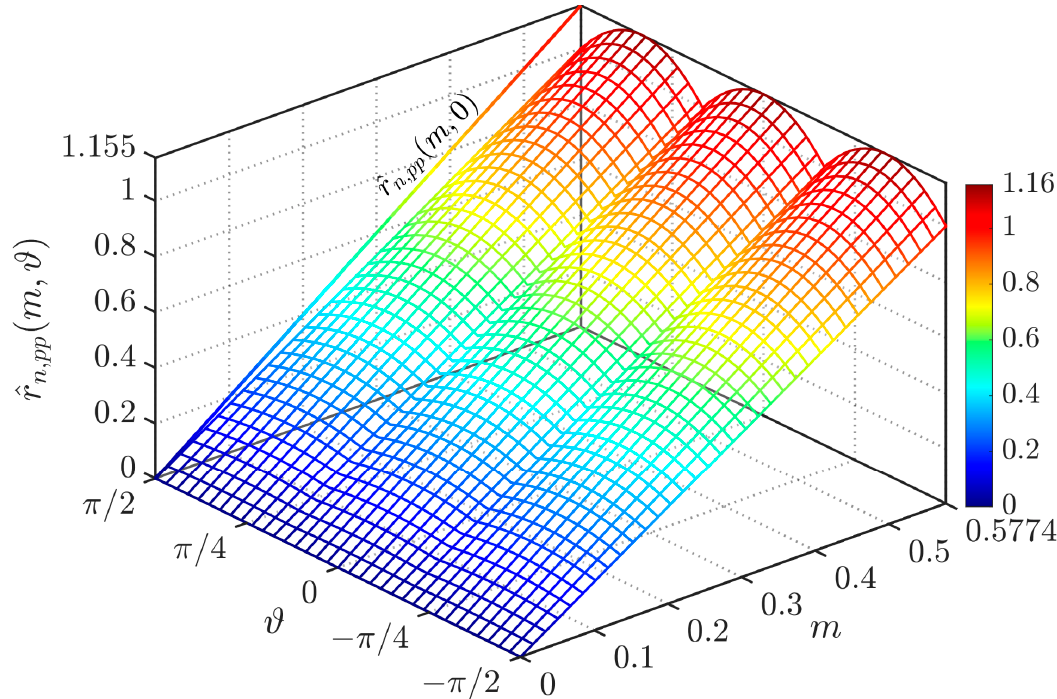
Figure 12. Normalized, peak-to-peak neutral current ripple in case of both SPWM and CPWM (up to m = 0.5 in case of SPMW).